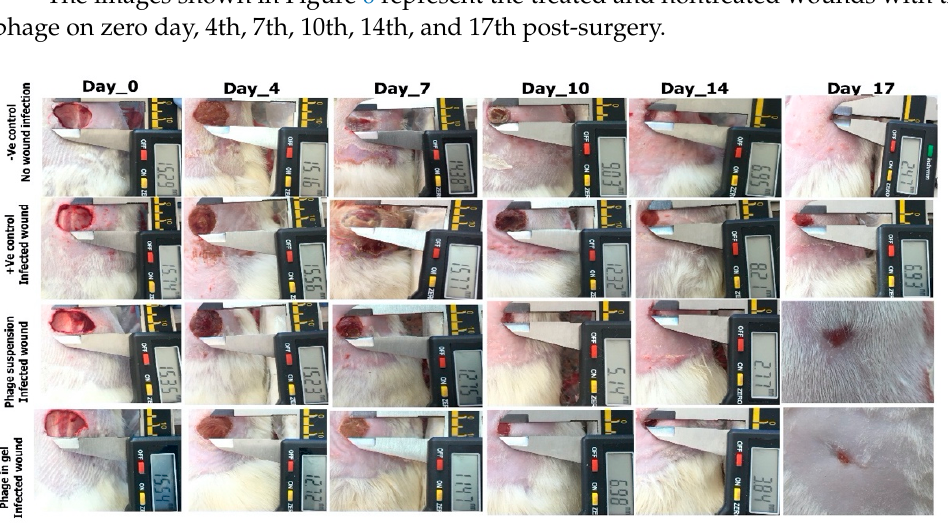
Figure 5. These diagrams represent the stability of phage ZCKP 8 at different temperatures ( A ), at different pH values ( B ), and under UV lamp ( C ). PFU: Plaque forming unit.